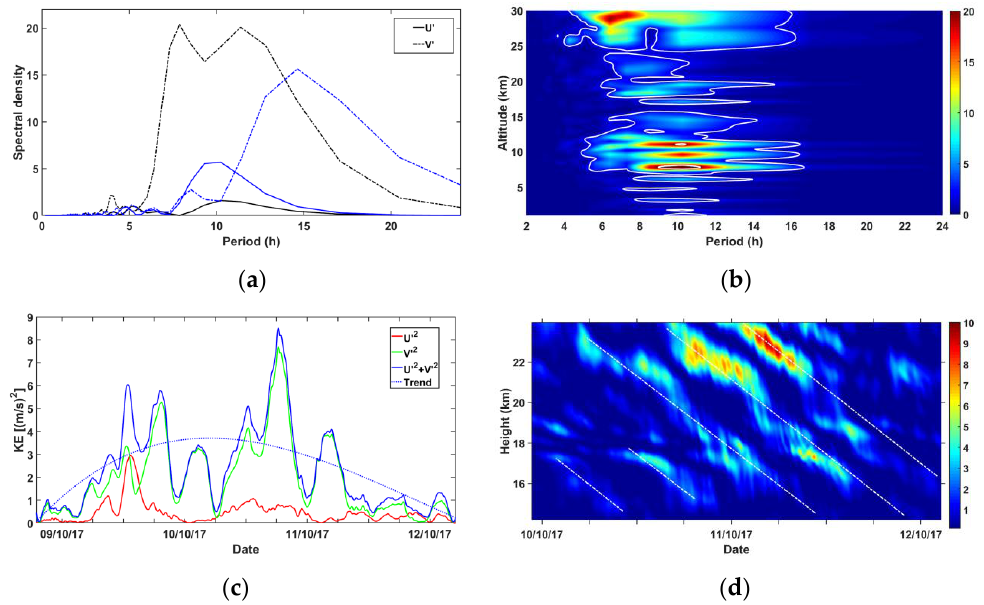
Figure 18. ( a ) Density spectral of 6 min zonal and meridional wind perturbations (U’ and V’) from 9 October 0000 UTC to 10 October 0300 UTC (black lines) and from 10 October 0000 UTC to 11 October 0300 UTC (blue line) at 11 km height for periods < 24 h; ( b ) mean density spectral of zonal and meridional wind perturbations as a function of the altitude; ( c ) time evolution of the mean kinetic energy (KE) in the zonal (U’ 2 ) and meridional (V’ 2 ) winds as well as the total one (KE = U’ 2 + V’ 2 ) at heights of 8 – 11 km from 9 October 0000 UTC to 12 October 1200 UTC. The dotted blue line is the trend of KE; ( d ) time – height distribution of the kinetic energy in the meridional wind (V’ 2 ) at heights of 14 – 24 km. Dotted white lines highlight structures of GWs with downward phase progression.